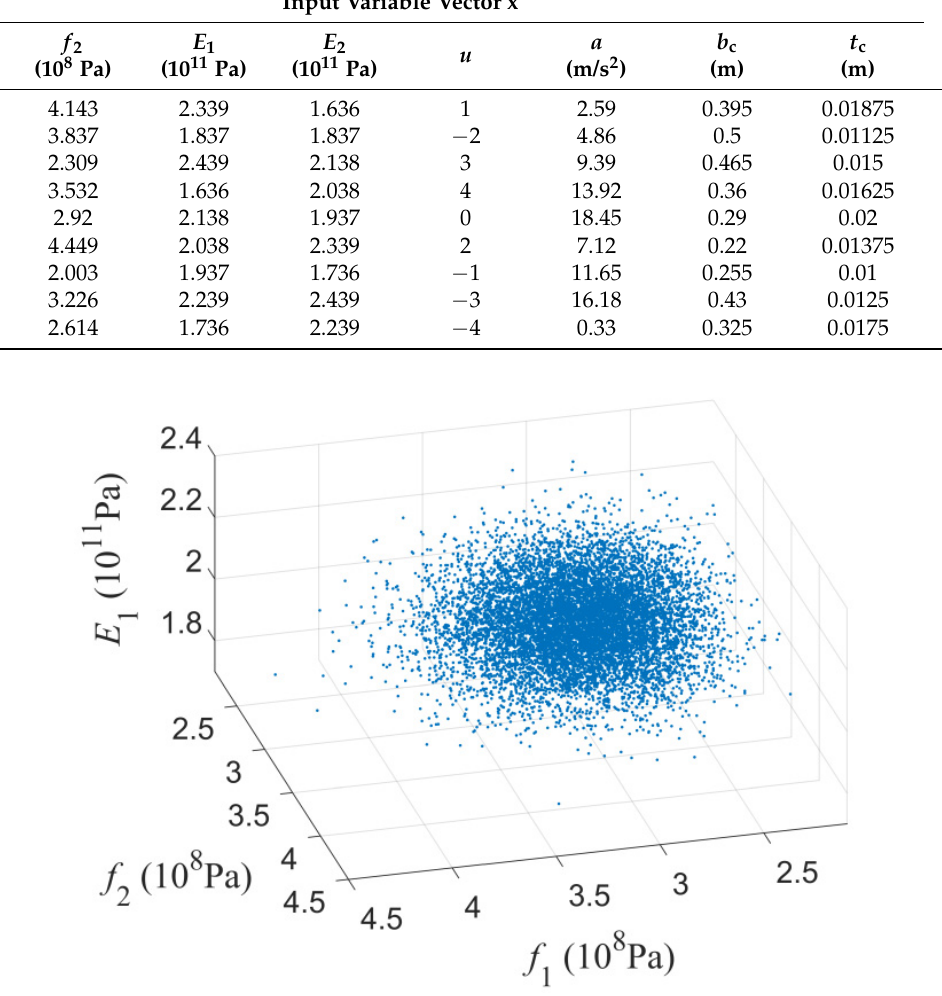
Figure 5. Candidate points.